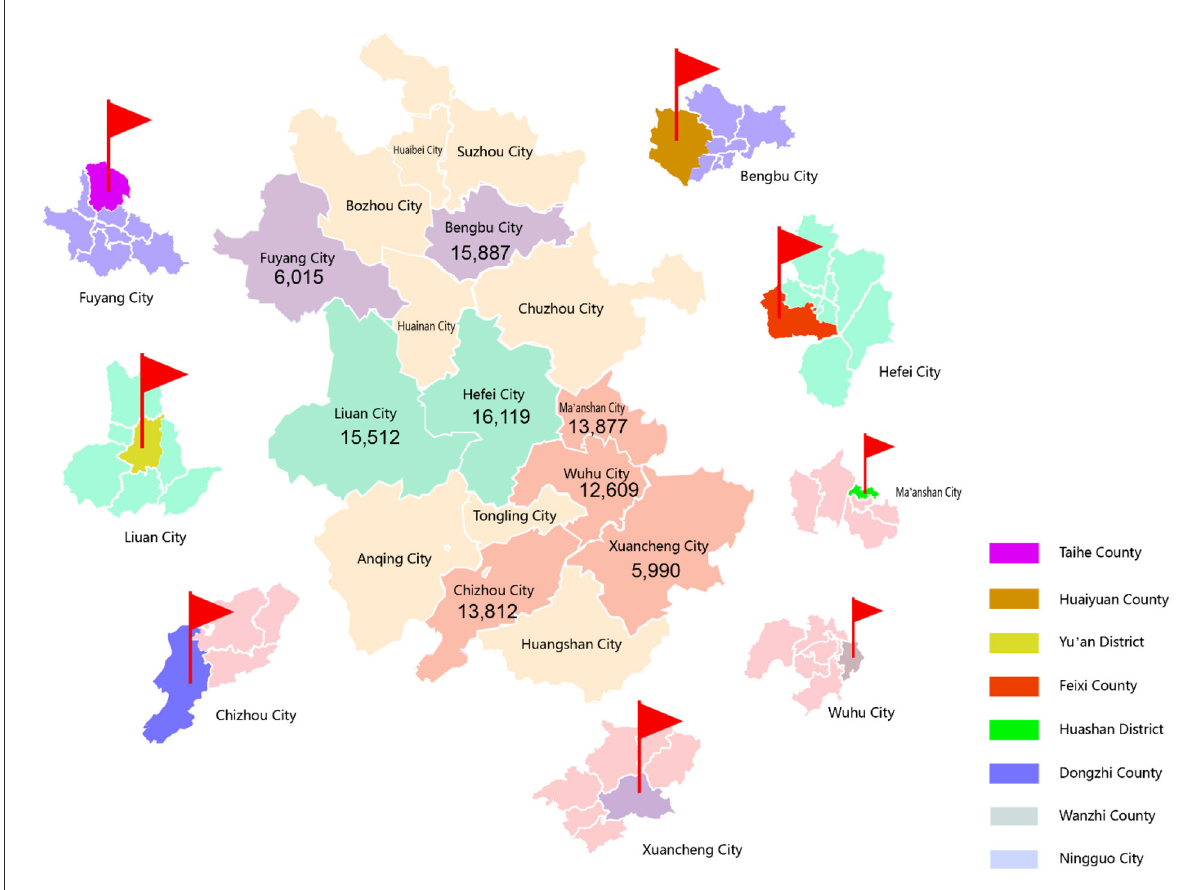
FIGURE1 Eight counties/districts participating in the